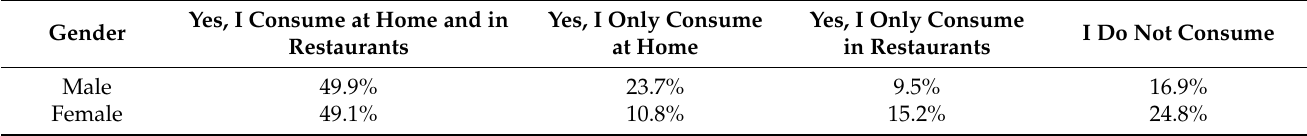
Table 5. Do you eat game-based foods (including p â t é , sausages, etc.) ( n = 523)?